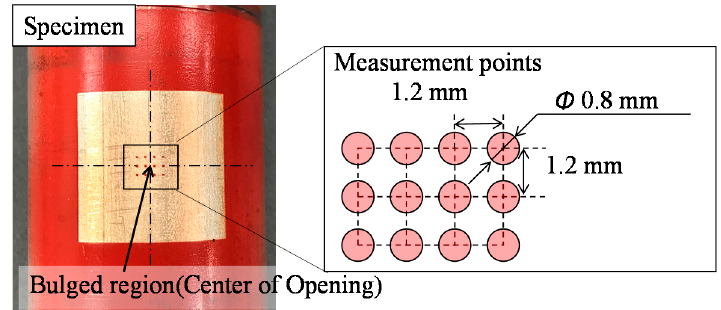
Figure 7. Size and shape of marking points for measurement by image processing.